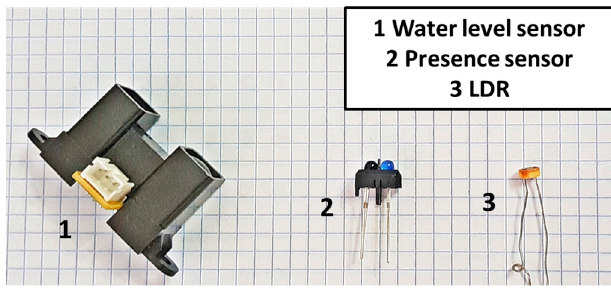
Figure 7. Employed components for sensor to monitor the tank.